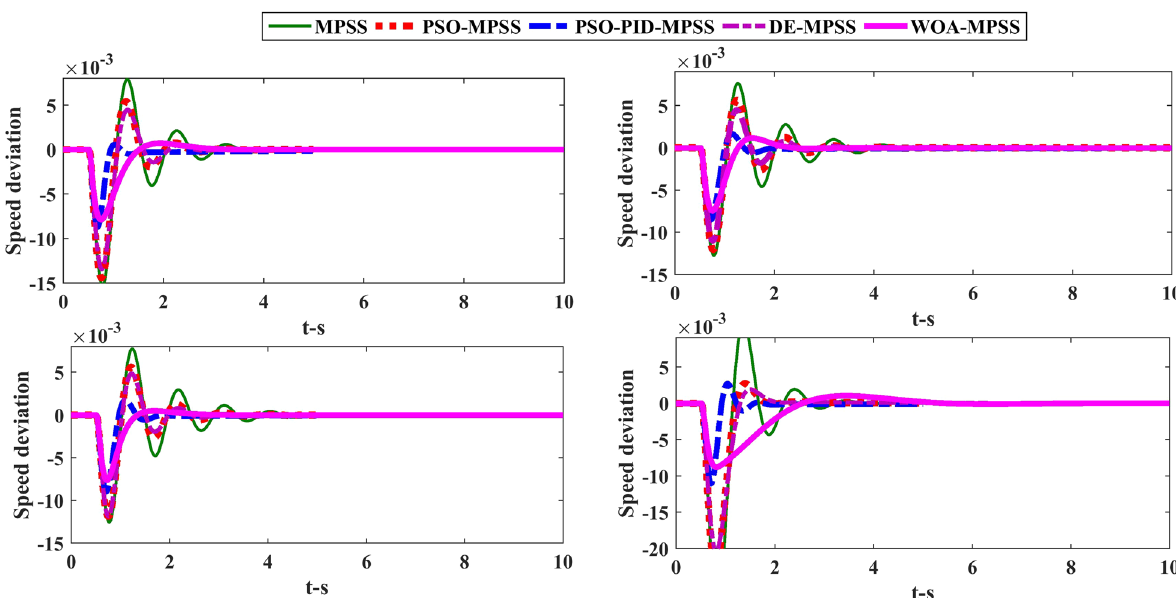
Fig. 7 System response plots for the disturbance of 10% step change at V